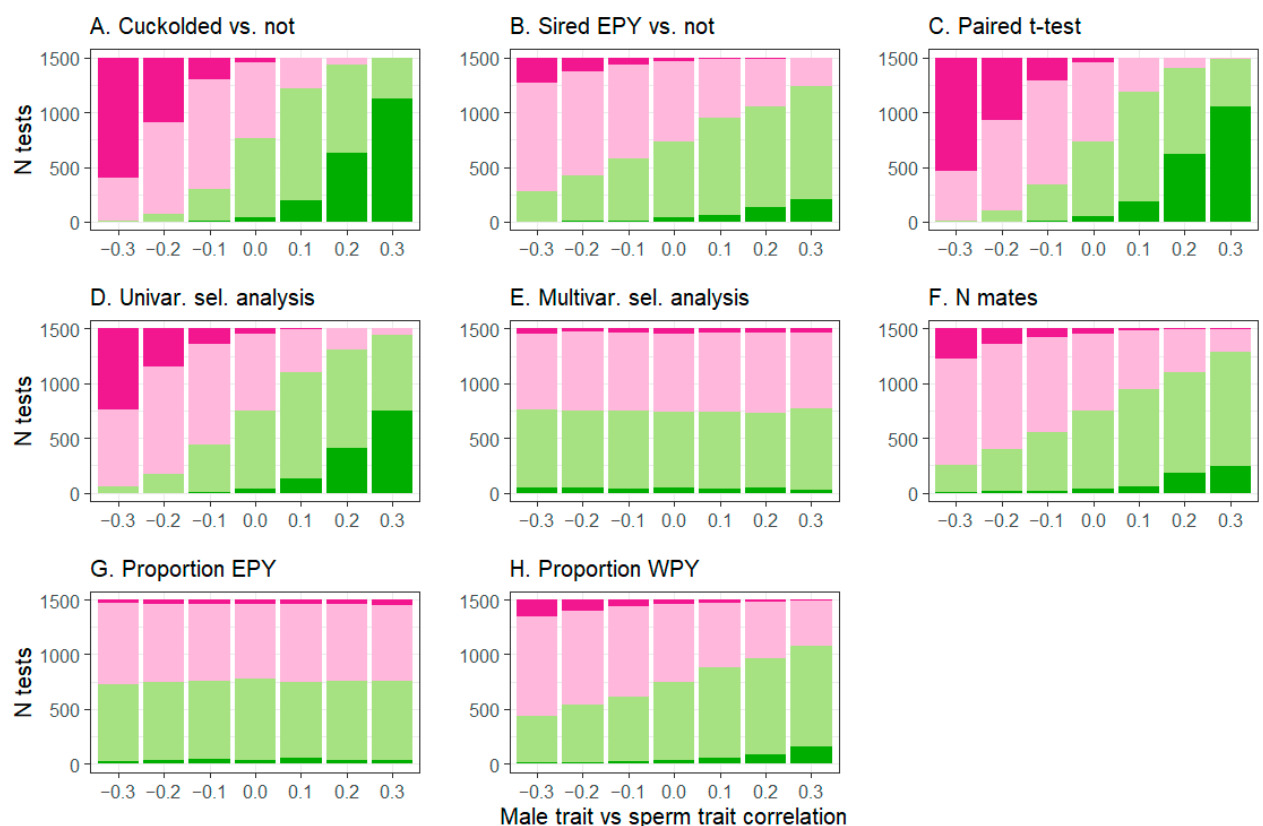
Figure 3. Spurious significant results for sperm traits (i.e., detected selection in individual populations where the sperm trait did not affect fertilization success) were common for most analytical approaches when the sperm trait correlated to a male trait under selection. Pink colors indicate estimated negative selection and green colors indicate positive selection; intense colors are significant test results, while lighter colors are non-significant. Analytical approaches were ( A ): unpaired t-tests of males that lost paternity within their own broods (were cuckolded) or did not; ( B ): unpaired t-tests of males that gained extra-pair young (EPY) in other broods or did not; ( C ): paired comparisons of extra-pair sires to the within-pair males that they cuckolded; ( D ): univariate selection analysis regressing offspring sired on the sperm trait; ( E ): multivariate selection analysis regressing offspring sired on both traits (with test results shown for the sperm trait only); ( F ) regression of the sperm trait on the number of detected extra-pair copulation partners; ( G ) regression of proportion of extra-pair brood sired on the sperm trait of extra-pair males, including only broods where the male sired at least one extra-pair young; and ( H ): regression of the proportion of within-pair young (WPY) on the sperm trait of the within-pair male, including only broods where the male lost paternity. Type 1 error is expected to produce only 5% (75) significant tests per column.